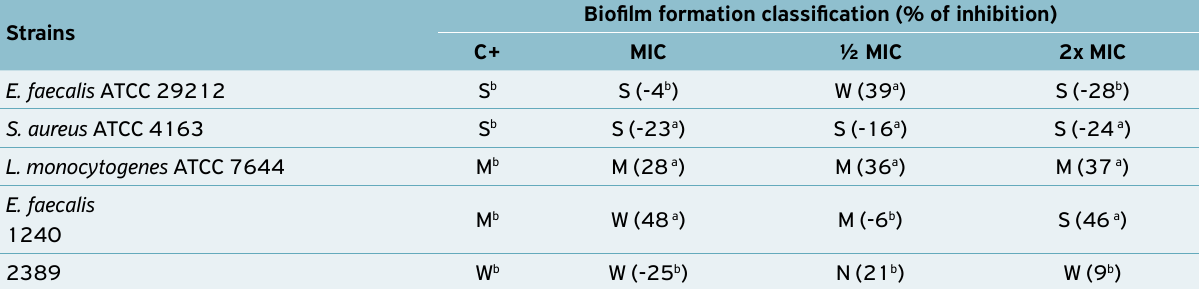
Table 5. Percentage of inhibition on the preformed biofilm of Enterococcus faecalis , Staphylococcus aureus and Listeria monocytogenes strains exposed to essential oil of dried leaves of Eucalyptus staigeriana (EO dl